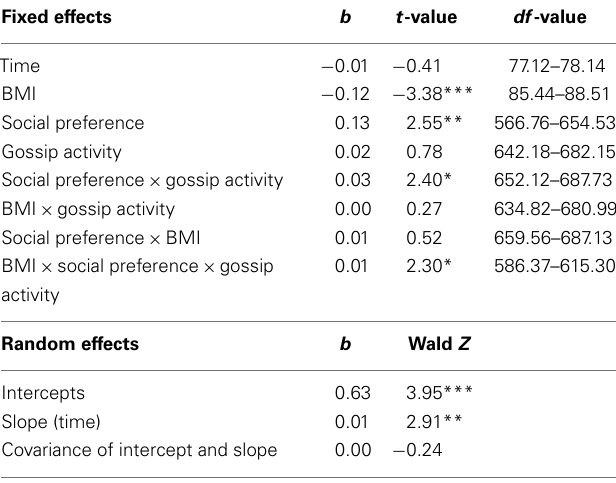
Table 1 | Fixed and random effects of multilevel analysis testing of the effect of BMI, social preference, gossip activity, and their respective interaction terms (IVs) on perceived social inclusion (DV).